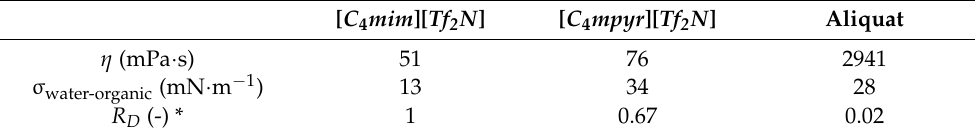
Table 1. Properties of [ C 4 mim ][ Tf 2 N ] and [ C 4 mpyr ][ Tf 2 N ] at 25 ◦ C and Aliquat at 23 ◦ C